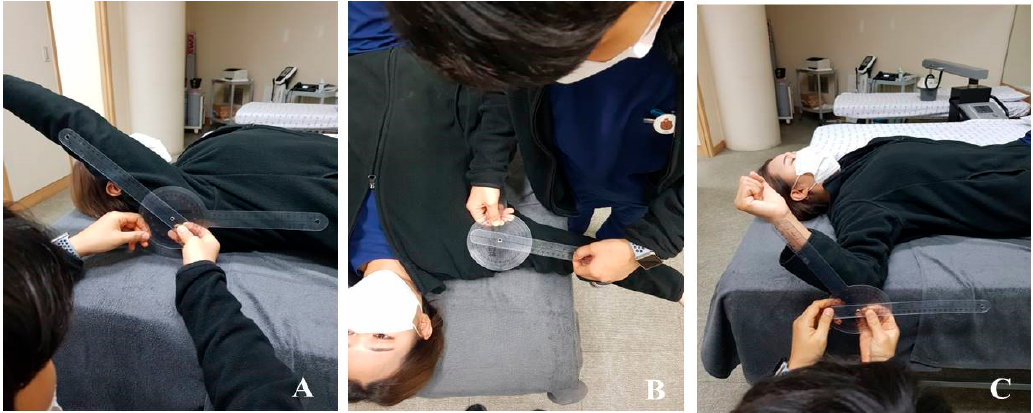
Figure 3. Measurement of the shoulder range of motion: ( A ) forward flexion; ( B ) abduction; ( C ) external rotation.